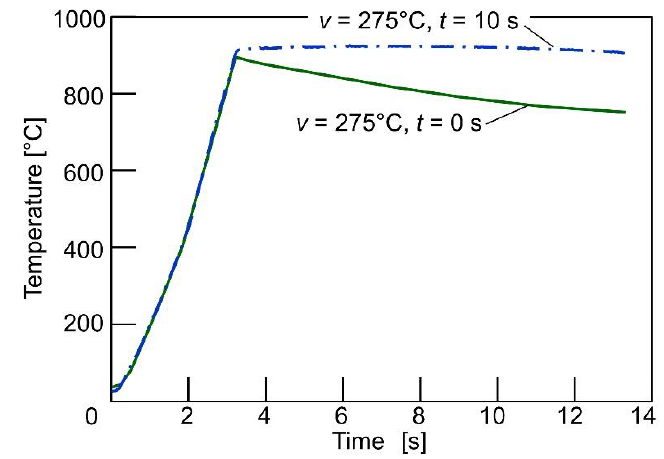
Figure 14. Variations in temperature in resistance heating for v = 275 °C/s and t = 0, 10 s.